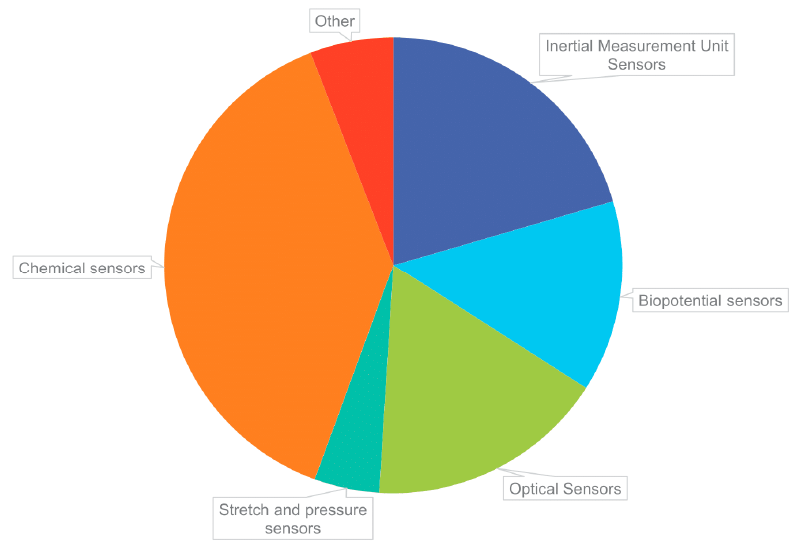
Figure 6. 2020 revenue from wearable sensors, the graph is provided by the market research report ‘Wearable Sensors 2021-2031’ IDTeachEx [239] . Copyright © 2021 IDTechEx Research. Some rights reserved.